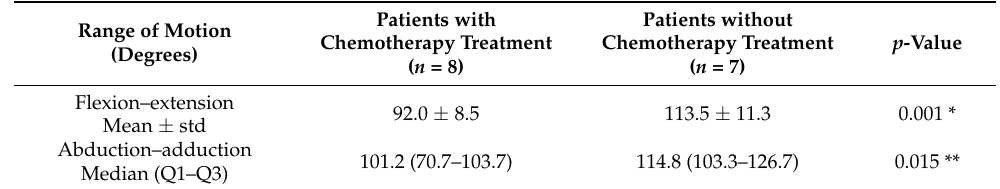
Table 2. Comparison of the range of motion of the glenohumeral joint, between patients who received chemotherapy and those who did not receive this treatment before